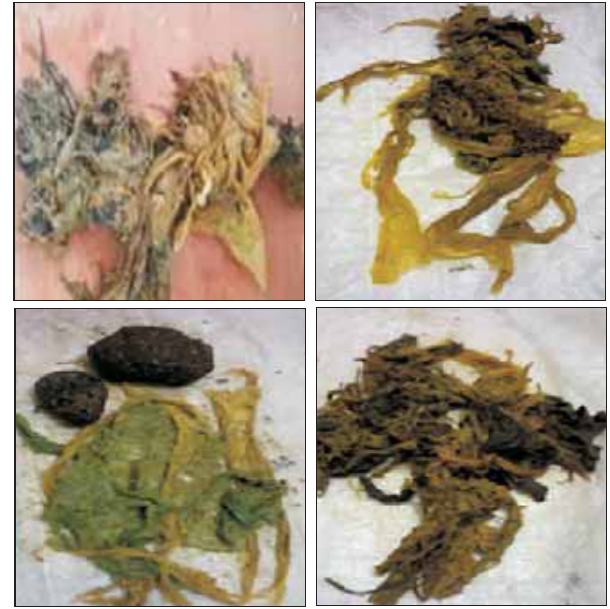
Figure-4: Different undigested foreign bodies found in rumen of diseased goat after slaughtering. A: Plastic bags with cloths, B: Plastic bags, C: Plastic bags and phytobezoar, D: plastic bags and robes.